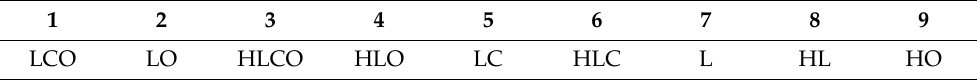
Table 6. Block configurations ranked by decreasing